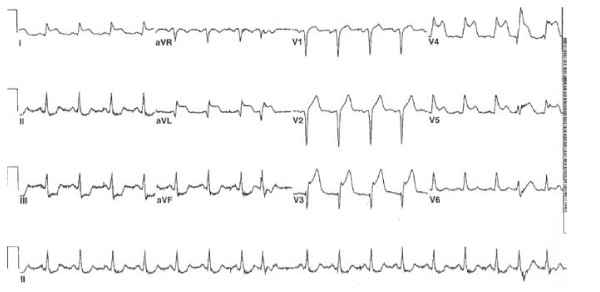
The EKG demonstrates ST segment elevation in leads I, III, aVL, and aVF, as well as precordial leads V2-V5. This suggests anterior wall ischemia and the patient underwent emergent coronary angiography.